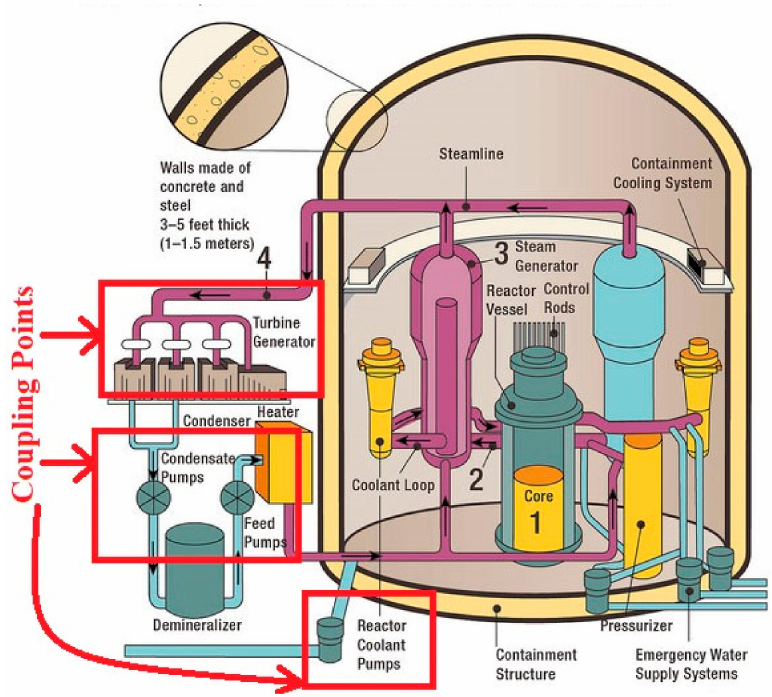
Figure 1. Typical thermomechanical diagram of a PWR [7].